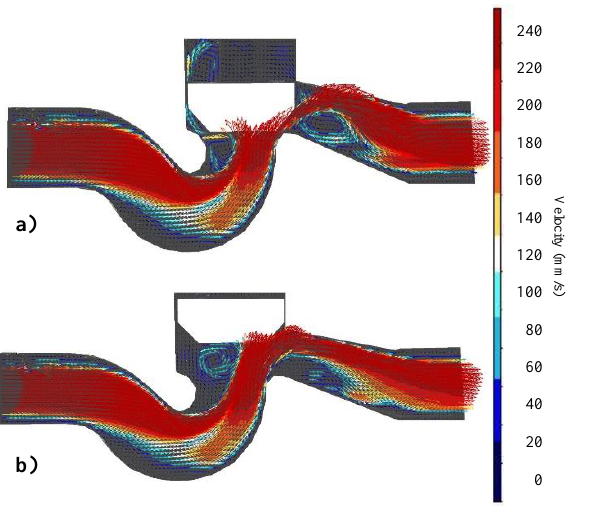
Fig. 8. Results of PIV measurements in the axial plane. Two regimes with the same flow rate but different plug